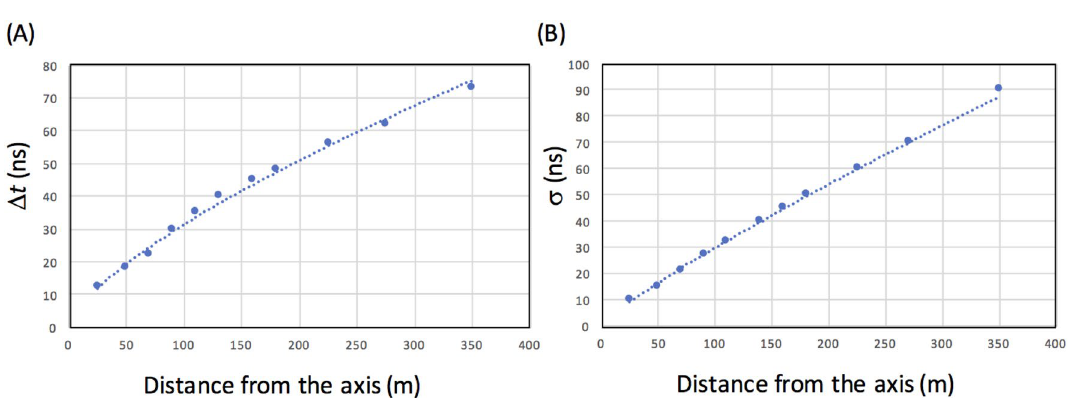
Figure 3. Time structure of the extended air shower initiated by the primaries with energies greater than 10 PeV. The EAS average arrival time (Δ t ) ( A ) and the disk thickness ( σ ) ( B ) are shown as a function of the distance from the shower axis. Filled circles indicate the experimental results as obtained with the KASCADE experiment 33